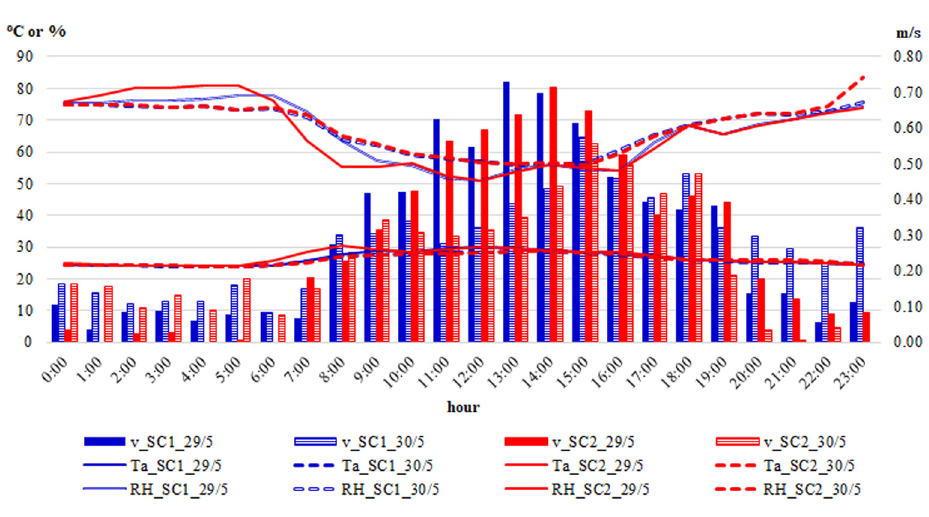
Fig. 12. Hourly microclimatic conditions of both street canyons measured on May 29 and May